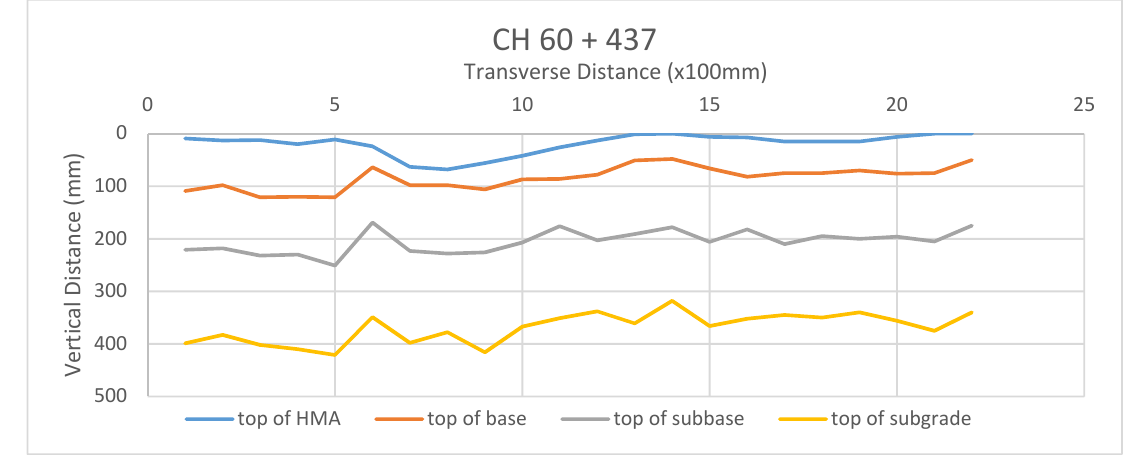
Figure 15. Profile of trench measurements of 60 + 437 km.